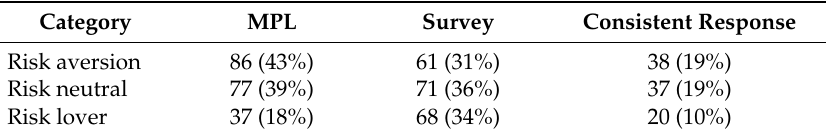
Table 6. Individuals’ risk preferences in MPL and self-assessment